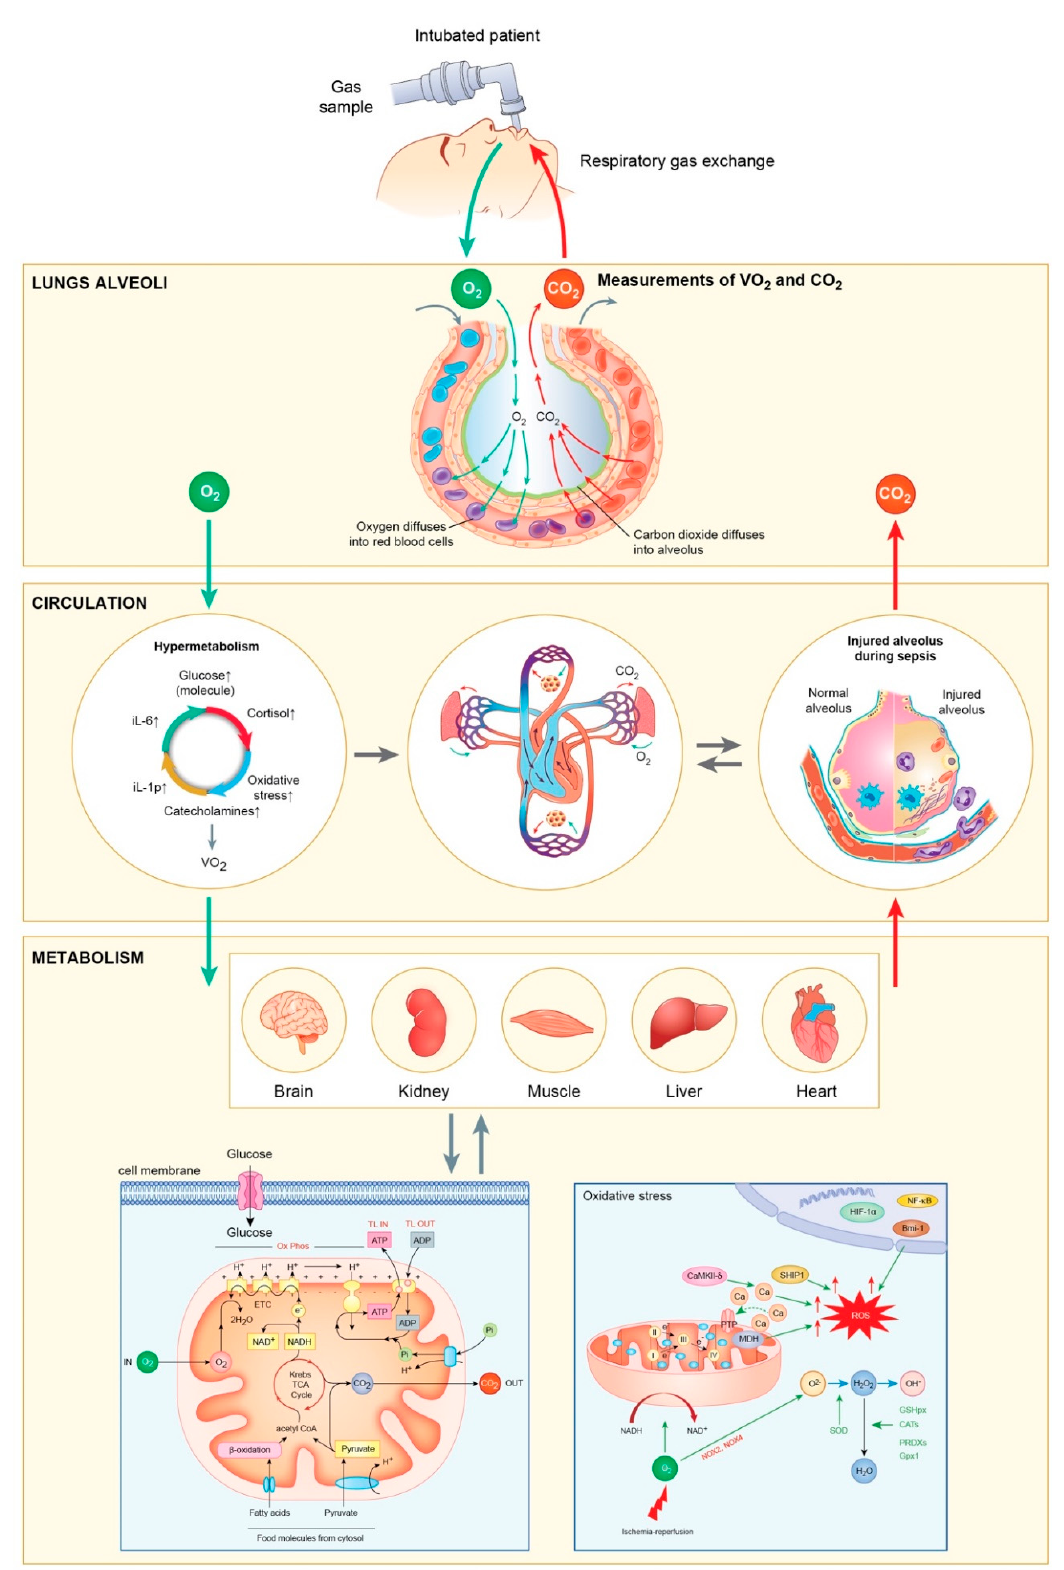
Figure 1. The entire metabolic process in the critical patient and the correlation with continuous gas exchange monitoring (VO 2 and VCO 2 ).